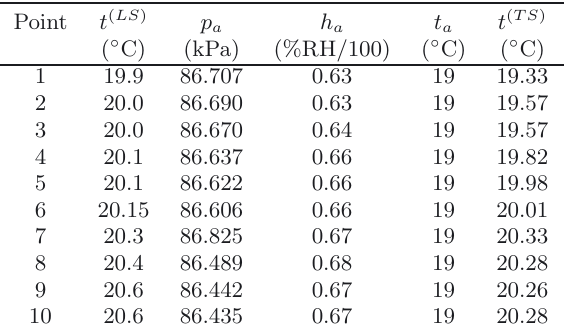
Table 2. Ambient and piston-cylinder temperature